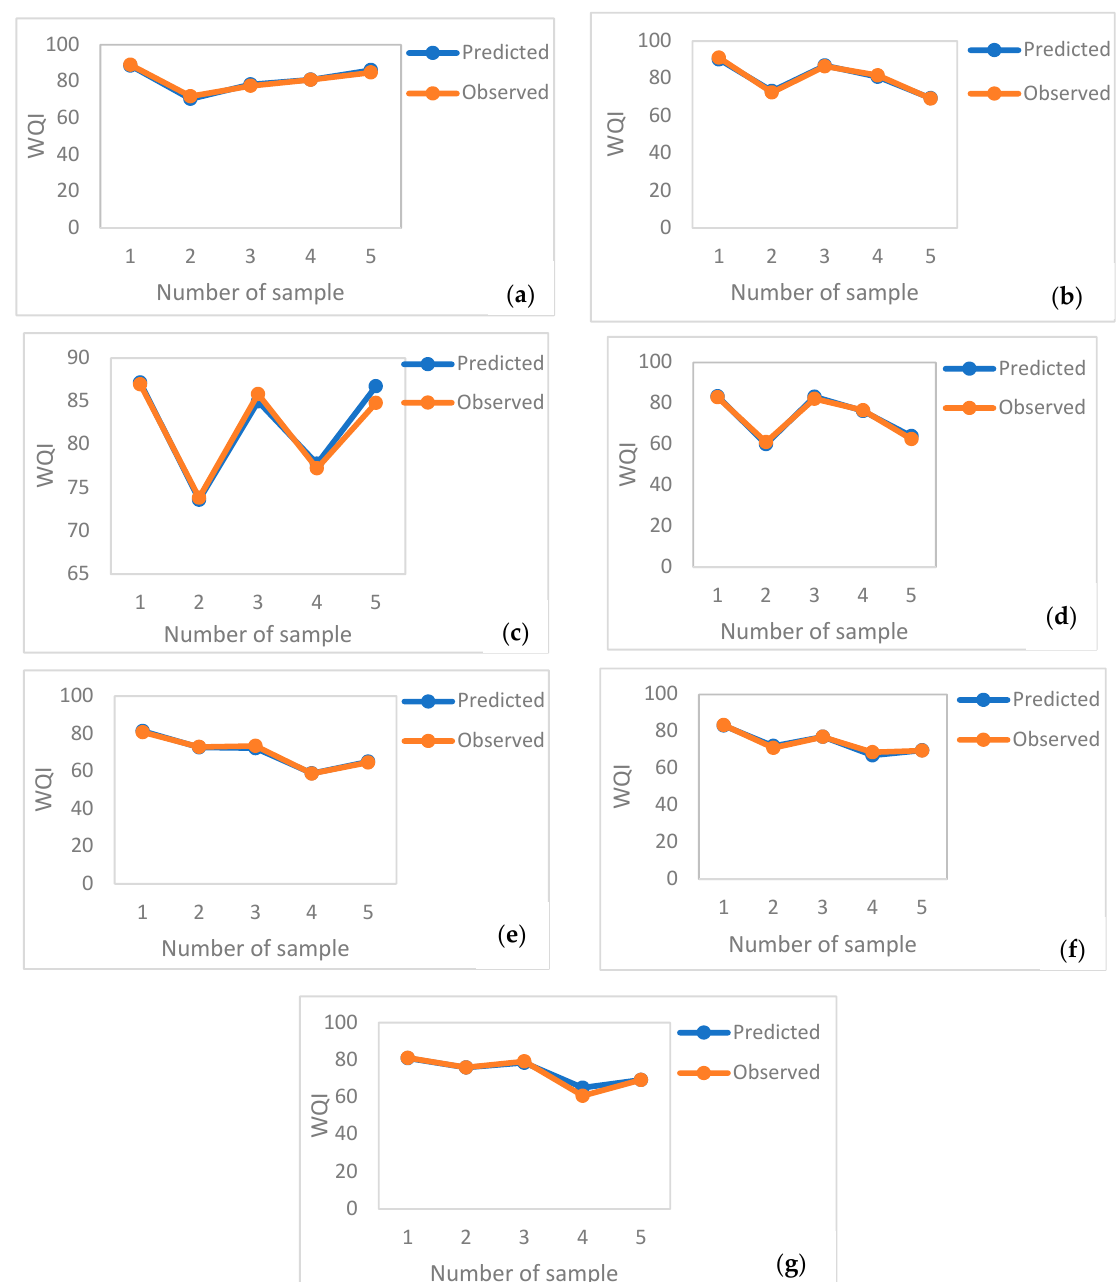
Figure 11. Series of observed and predicted WQI values during ( a ) upstream, ( b ) discharge point, ( c ) A, ( d ) B, ( e ) C, ( f ) D, and ( g ) E training phases in the wet season. Table 10. Performance of the ANN model for the wet season.